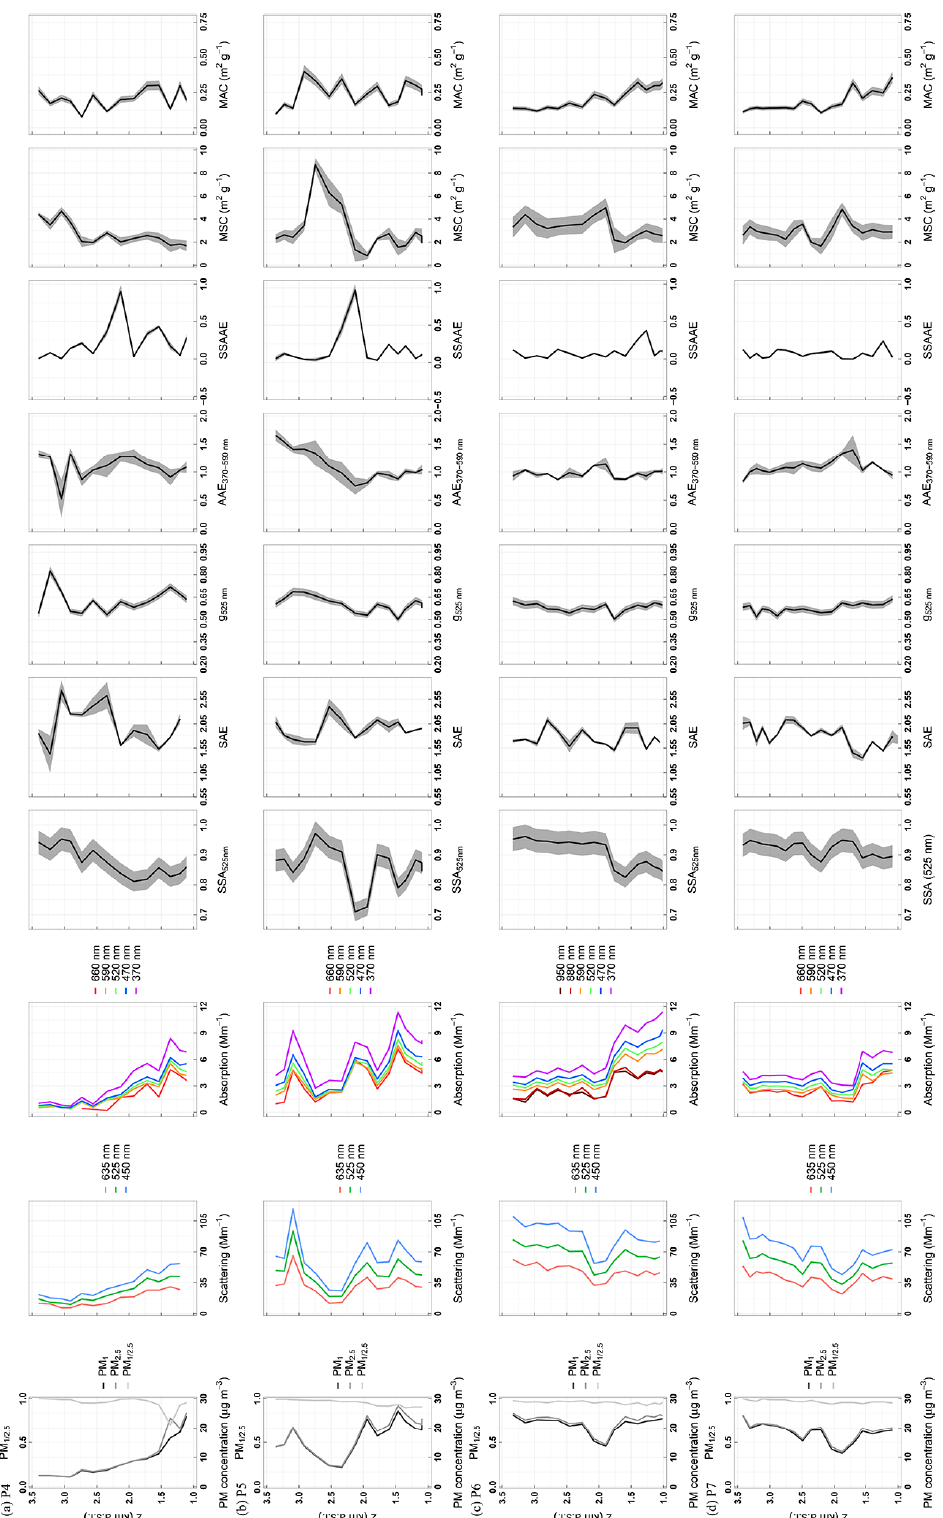
Figure 8. Vertical profiles from the extensive and intensive optical properties, as in Fig. 7 plus the asymmetry parameter ( g ), for the aircraft- borne measurements during the REG period for the (a) P4, (b) P5, (c) P6 and (d) P7 vertical profiles around the Catalan pre-coastal mountain range close to the MSY station. The shadowed areas around the intensive optical properties denote the standard error of the variables.